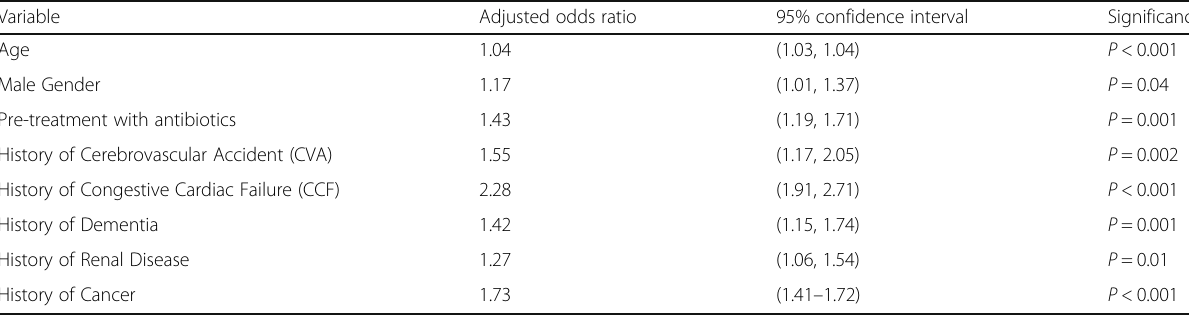
Table 4 Multivariate analysis of variables associated with in-hospital mortality Variable Adjusted odds